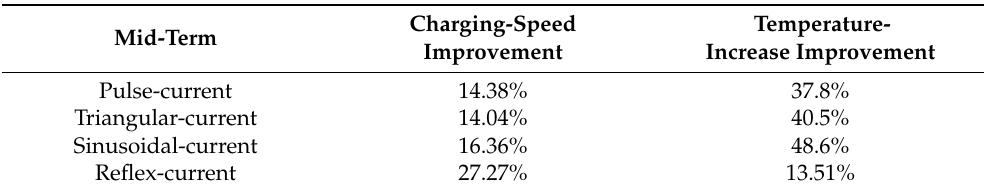
Table 5. Improvement of the four non-constant-current charging methods compared with the CC charging method under the waveform frequency = 4.7